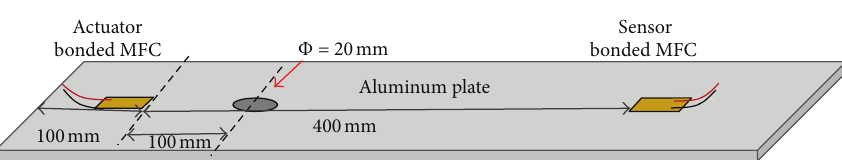
Figure 6: The envelope of signals obtained from different bonding conditions.